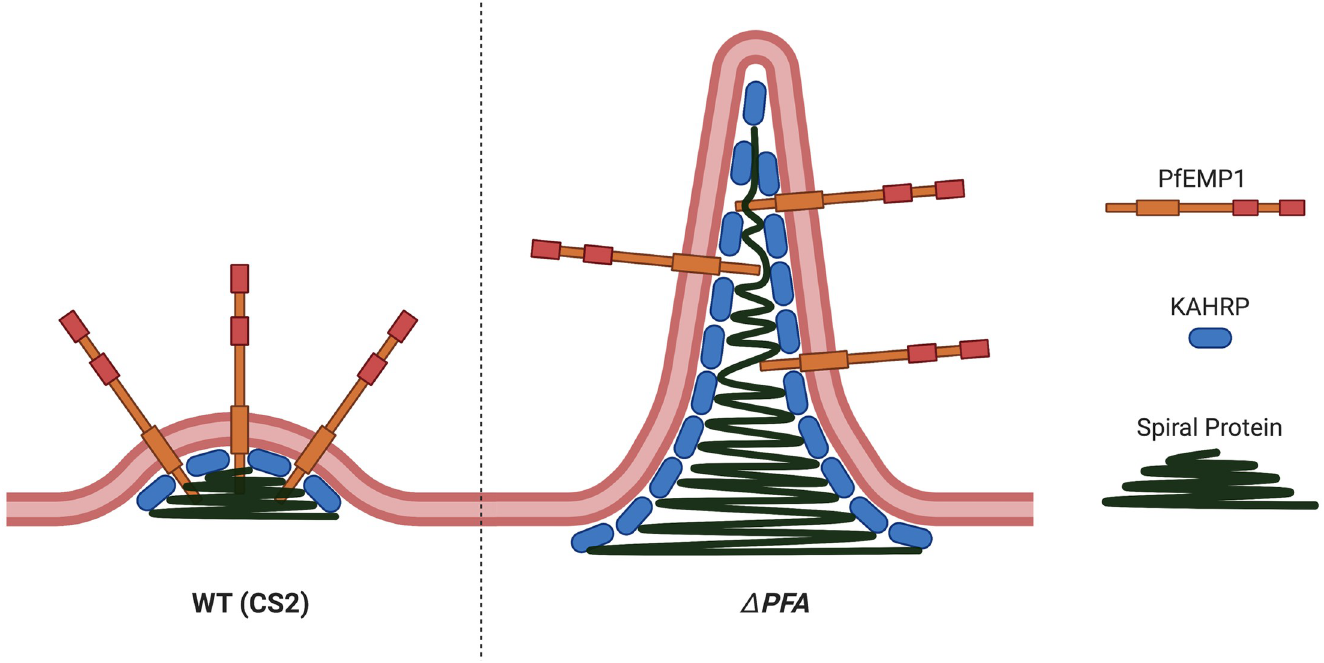
Fig 7. Proposed model for eKnob formation and structure. In opposition to normal knob formation in the CS2 cell line (left) runaway extension of the spiral underlying eKnobs in Δ PFA could drive their elongation (right). KAHRP is still present and associated with the inner lumen of eKnobs, PfEMP1 anchored in the eKnobs is incorrectly presented and has thus a reduced cytoadherence